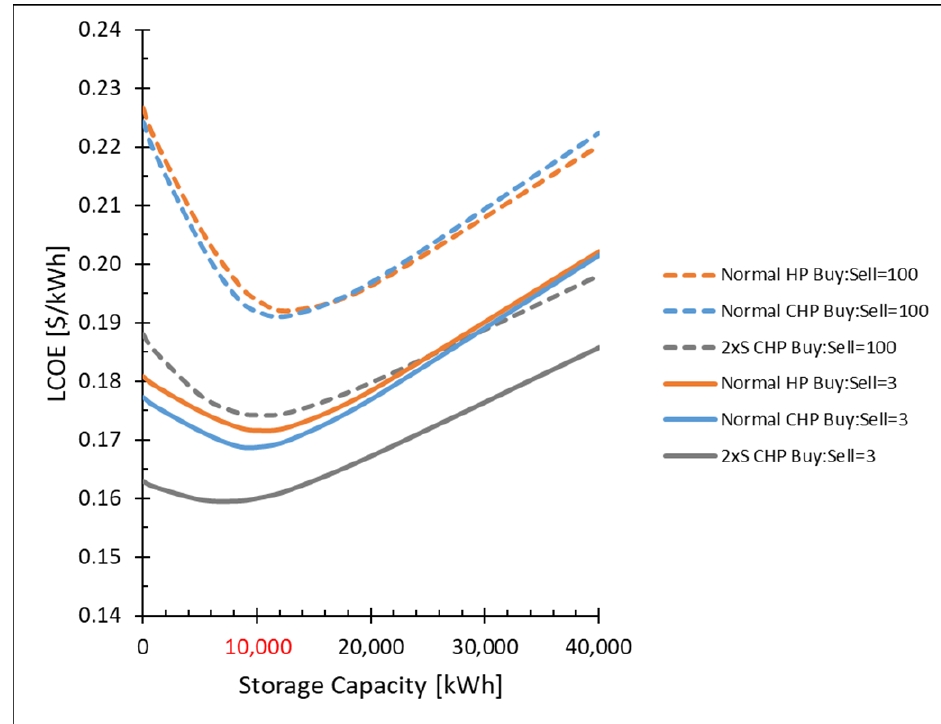
Figure 7. Levelized cost of electricity (LCOE) as a function of storage. Results are plotted for net-zero energy scenarios with buy:sell ratio traces of 3 and 100. For all scenarios and buy:sell ratios, the levelized cost optimized storage capacity is near 10,000 kWh (~30% of annualized daily electric load), which is the capacity assumed in the remainder of this